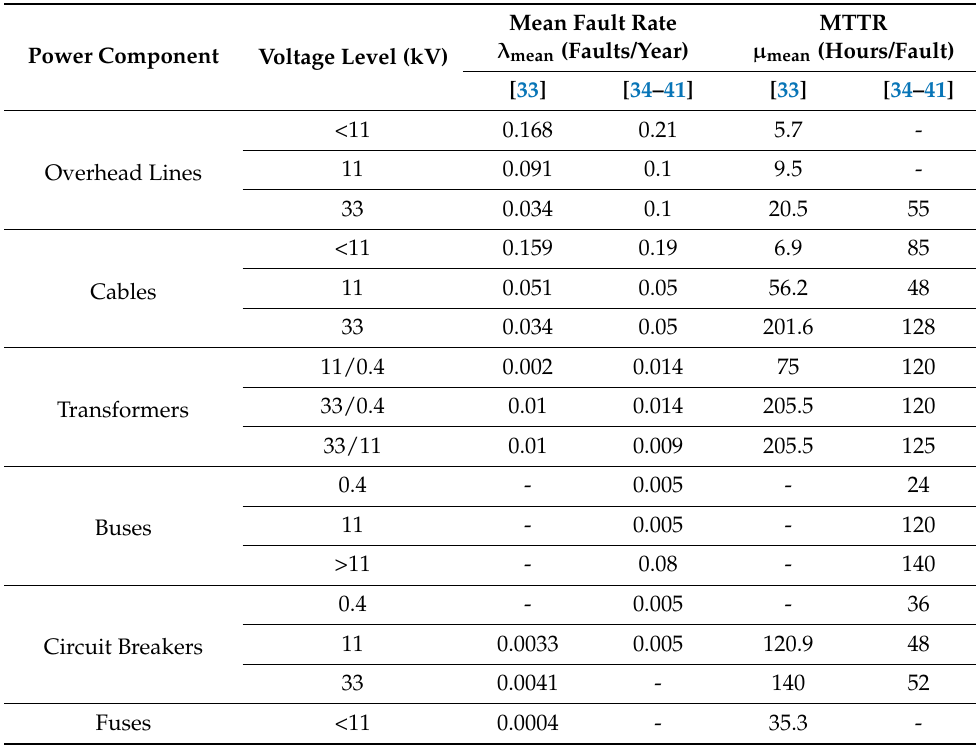
Table 3. Mean Fault Rates and MTTR of Power